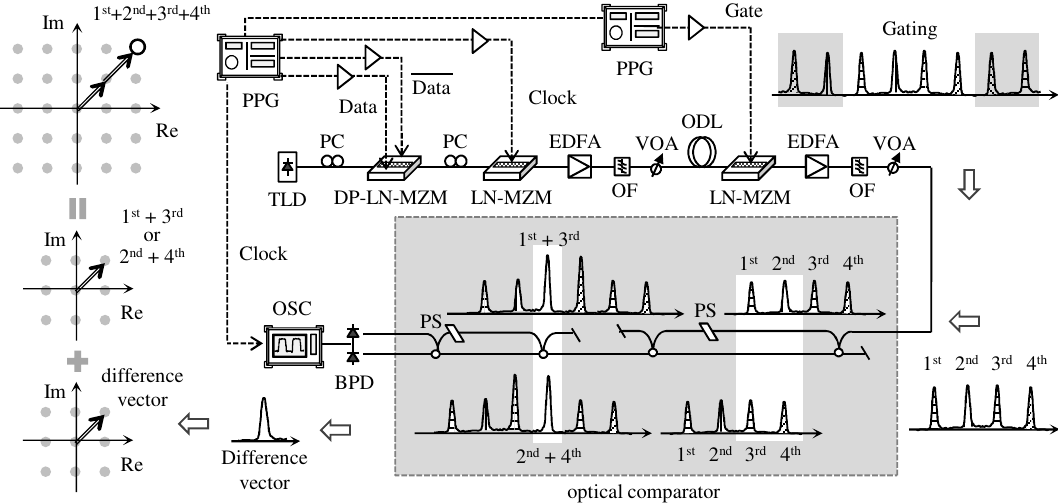
Figure 2. Experimental setup of an optical comparator for 8-bit QPSK signal. In this figure, the comparator comprises a serially cascaded two delay line interferometers (DLIs), whose FSRs are 5 and 10 GHz, respectively. The comparator generates a coupled symbol from four QPSK symbols with predetermined phase rotations. BPD: balanced photo detector; DP-LN-MZM: dual-parallel lithium-niobate Mach-Zehnder modulator; EDFA: erbium-doped fiber amplifier; ODL: optical delay line; OF: optical filter; OSC: oscilloscope; PC: polarization controller; PPG: pulse pattern generator; PS: phase shifter; TLD: tunable laser diode; VOA: variable optical